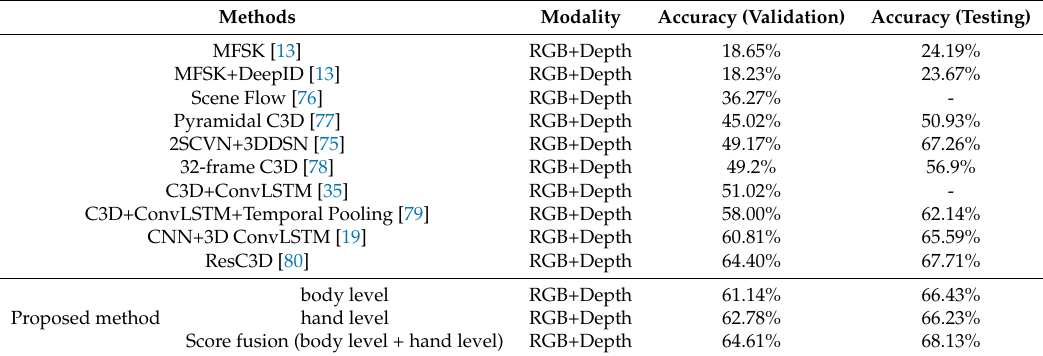
Figure 3. Examples of image frames at the body level and hand level. From up to bottom: body level RGB images, hand level RGB images, body level depth images and hand level depth images. Table 9. Comparison of the proposed method with other methods on the validation set and the test set of the ChaLearn LAP